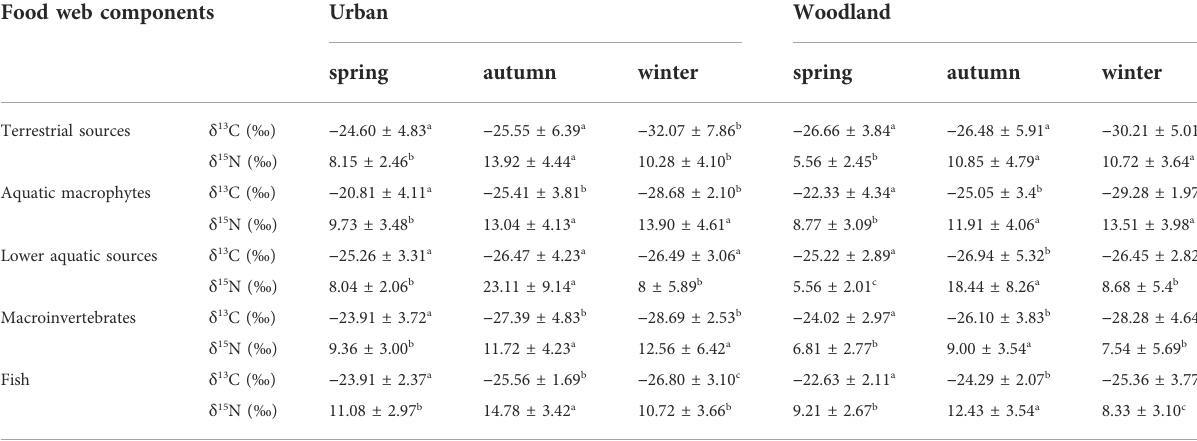
TABLE2Mean±SDof δ 13 Cand δ 15 Nisotoperatiosofbasalresources,macroinvertebrates,and fi shaturbanandwoodlandsitesinspring,autumn,and winter. Food web